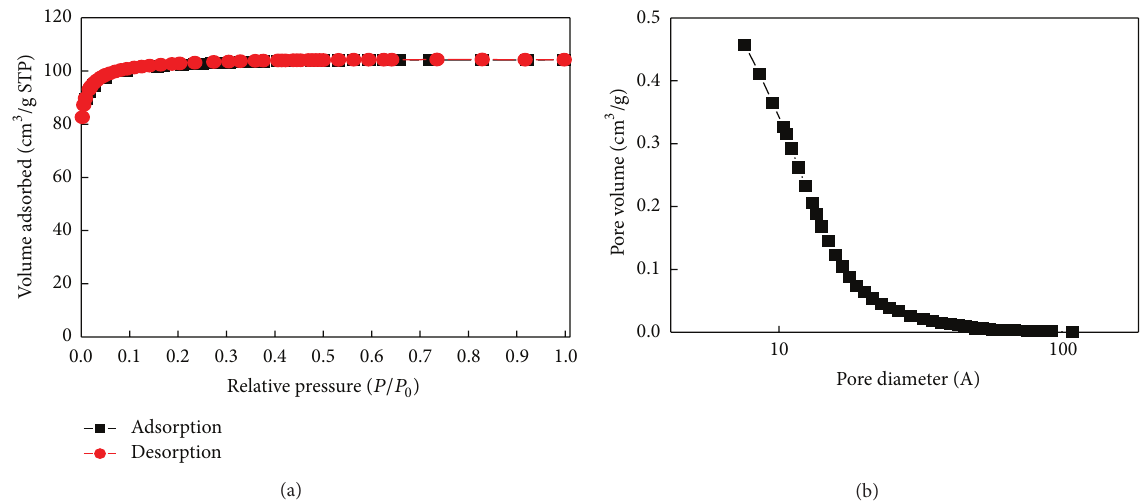
Figure 2: (a) Nitrogen adsorption-desorption isotherm and (b) pore size distribution of 0.6 wt% Fe-TiO 2 /SAC.